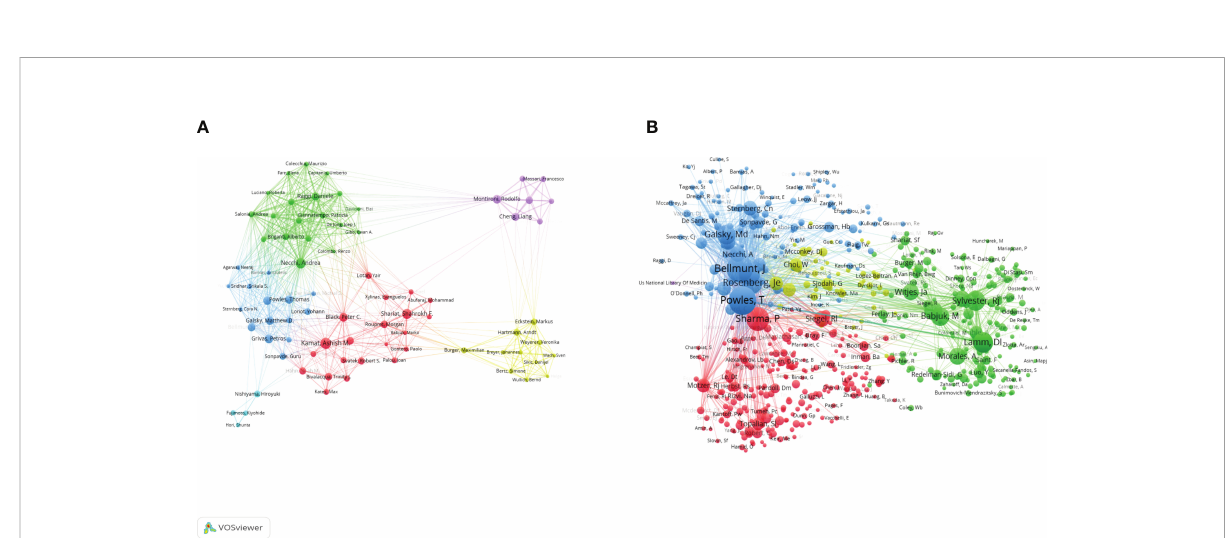
FIGURE 6 Visualization map of co-authorship (A) and co-citation (B) analyses of authors generated by VOSviewer